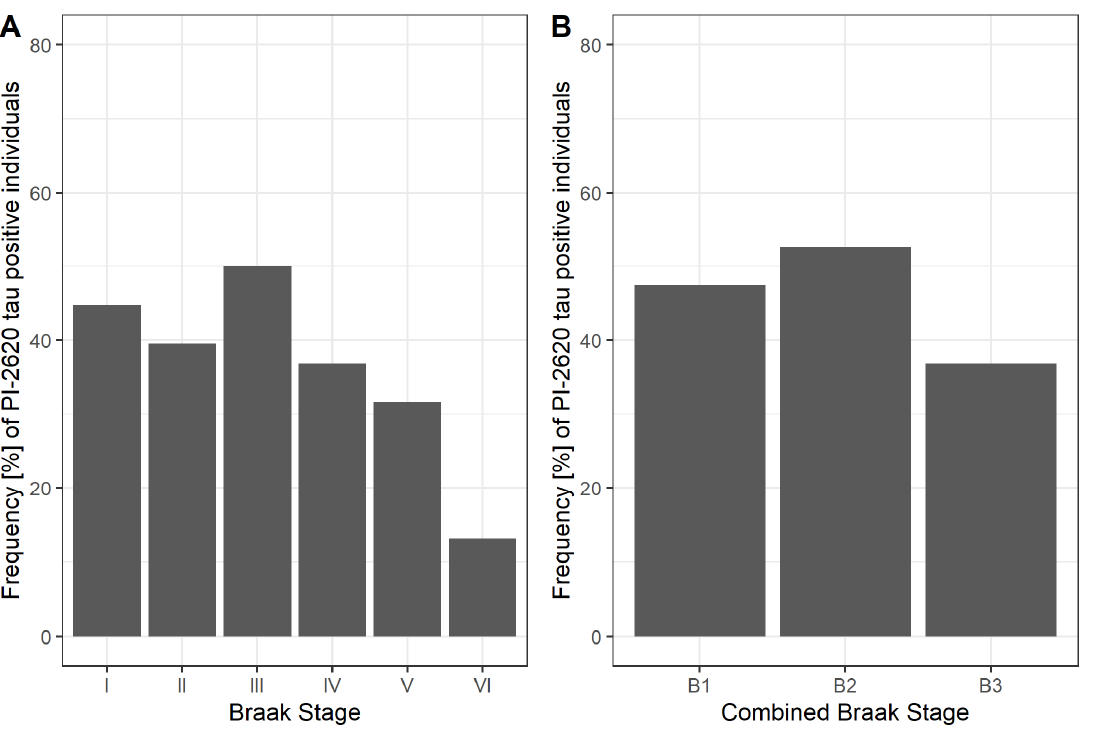
Figure 1. Frequency of 18 F-PI-2620 tau PET positivity for ( A ) each Braak stage and ( B ) the combined Braak stage model.